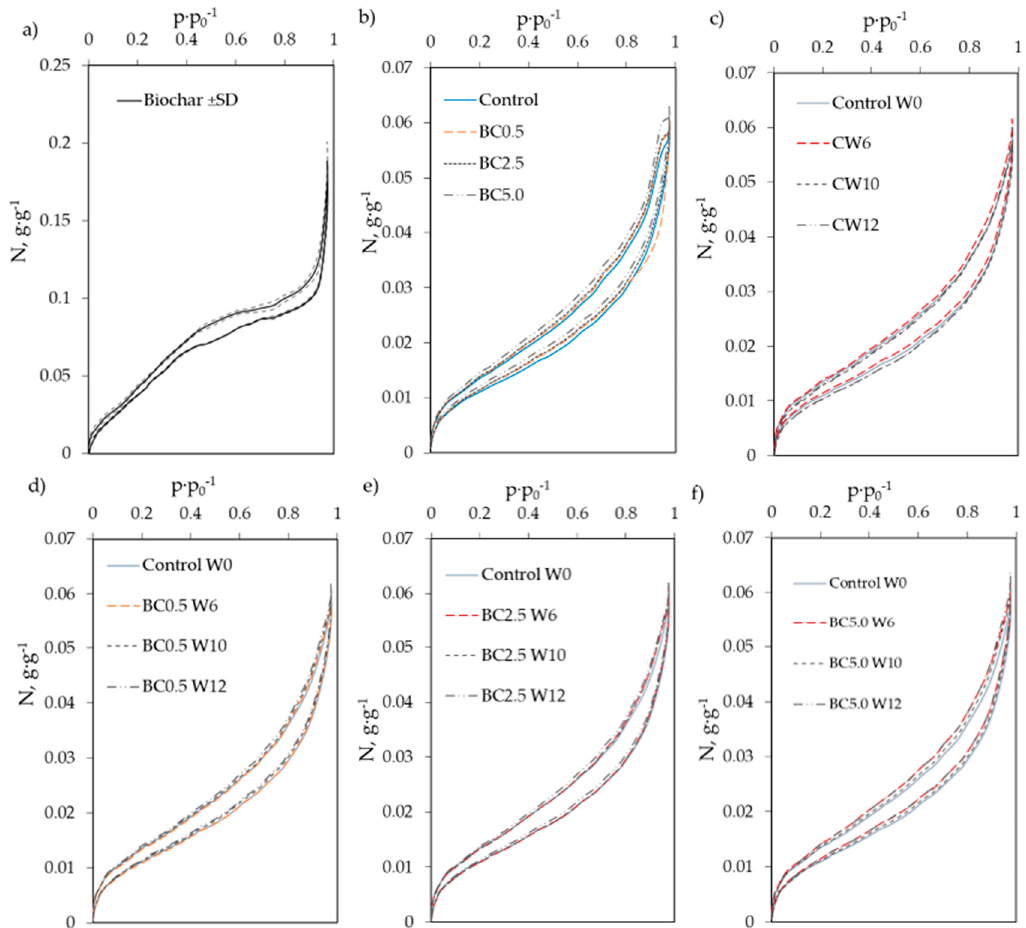
Figure 2. Adsorption (lower curves) and desorption (upper curves) isotherms and hysteresis loops obtained for the ( a ) biochar only, ( b ) for the di ff erent treatments at the end of the experiment, ( c ) control, ( d ) BC0.5, ( e ) BC2.5, and ( f ) BC5.0. BC0.5, BC2.5, and BC5.0 represent 0.5%, 2.5%, and 5.0% biochar amended soil, respectively. W represents the number of weeks when sampling occurred. N means the quantity